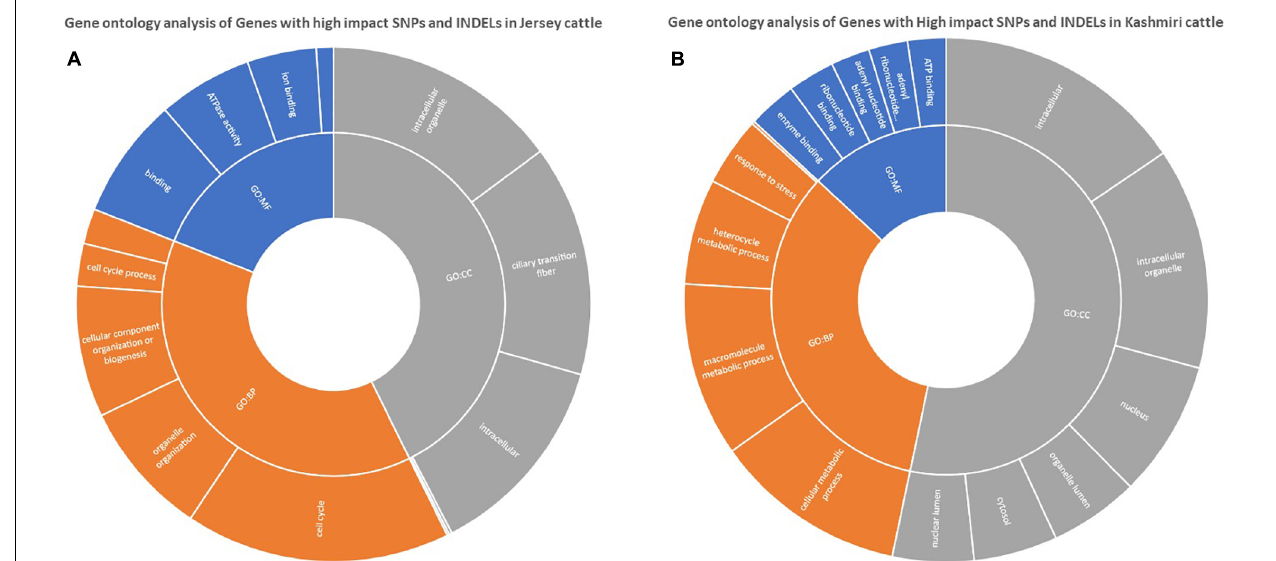
FIGURE 2 | GO enrichment analysis of genes with high impact variations in Jersey (A) and Kashmiri (B) cattles.